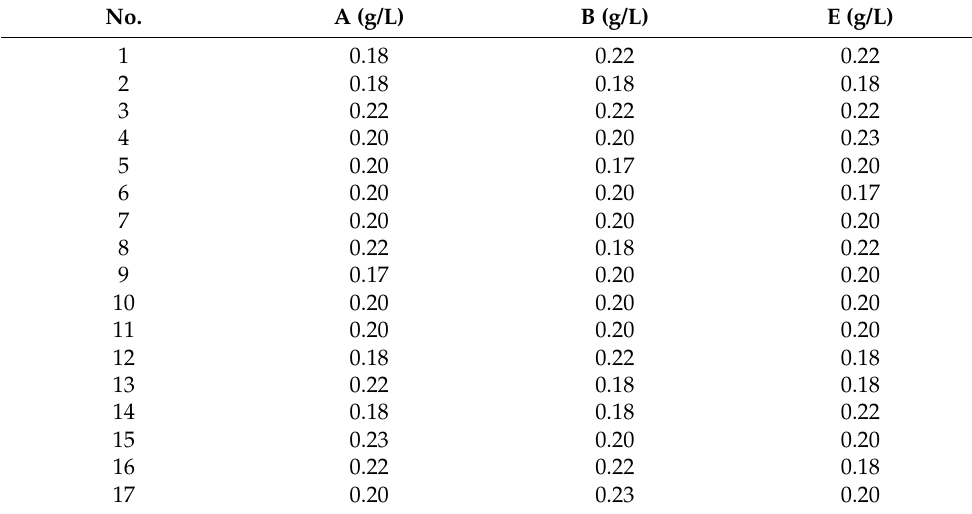
Table 3. Experimental design using CCD of three independent variables with their coded and actual